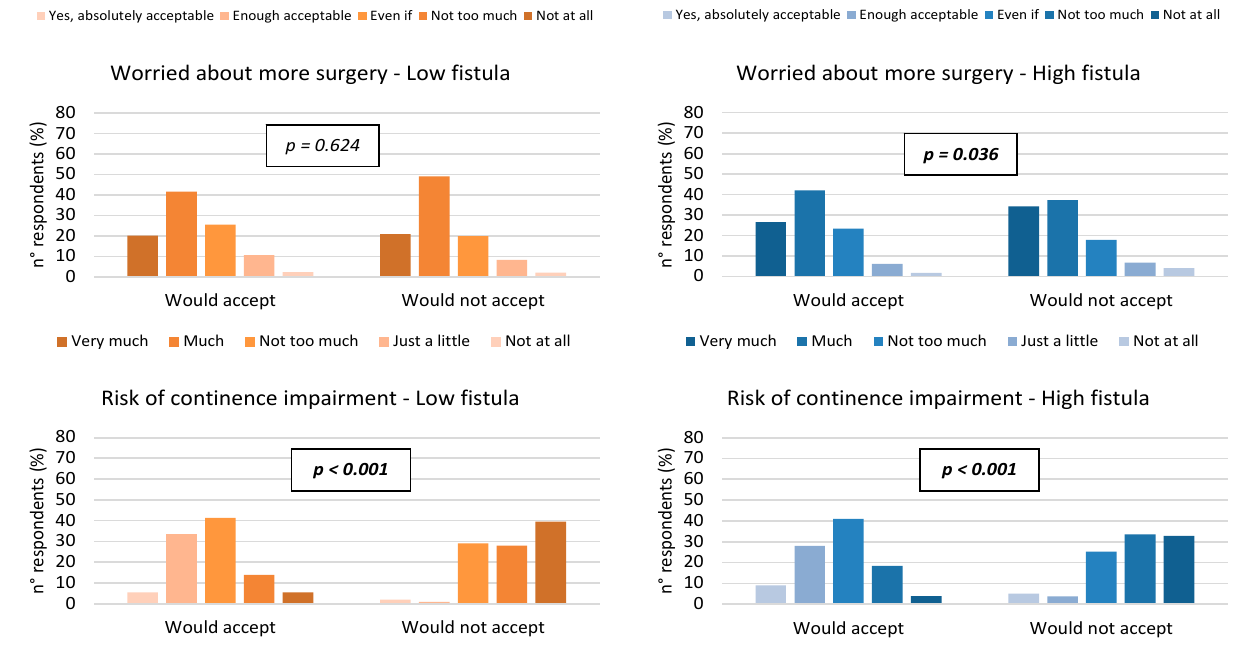
Figure 2. Comparison of respondents’ opinions between who would and would not agree to be submitted to fistulotomy in low and high anal fistula, separately (chi-squared test). QoL = quality of life; Even if = considerable.